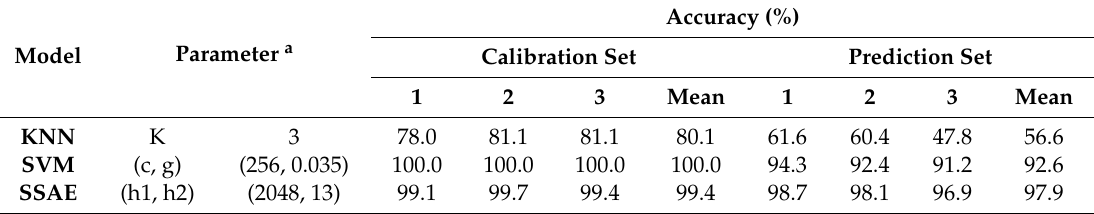
Table 1. Classification results of discriminant models based on full spectra.